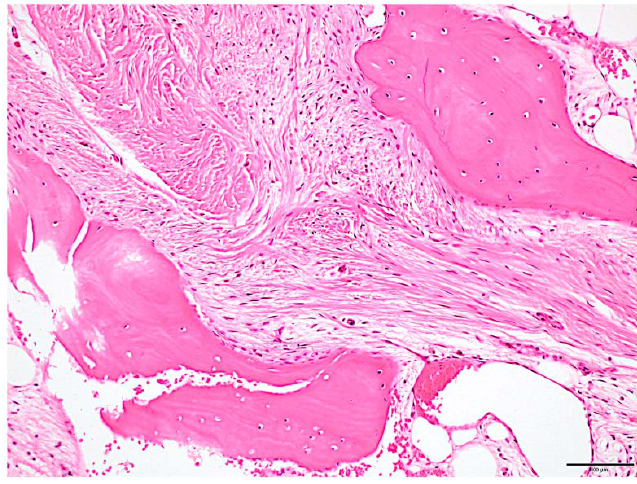
Figure 5. Histologic features. Irregular osteogenic image of bone beam pattern with fibrous connective tissue background was observed. Fibrous bone had poor osteoblast lining. Scale bar: 100 µ m.